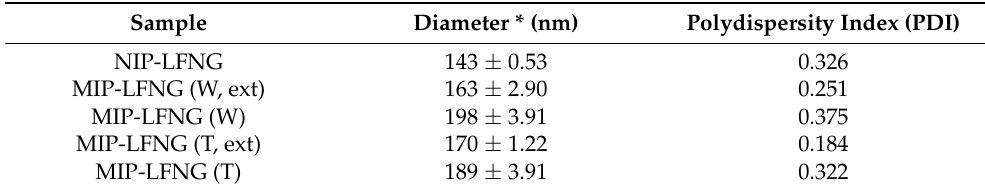
Table 2. DLS results of LFNGs before and after PLA2 template